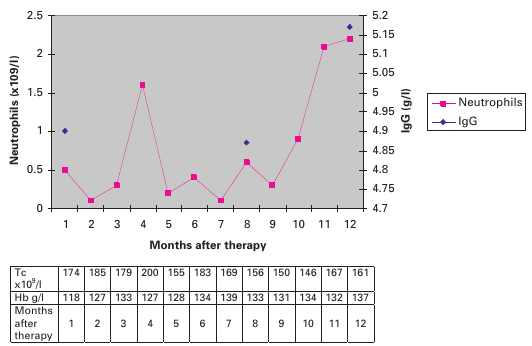
Neutrophils and serum IgG after chemotherapy and